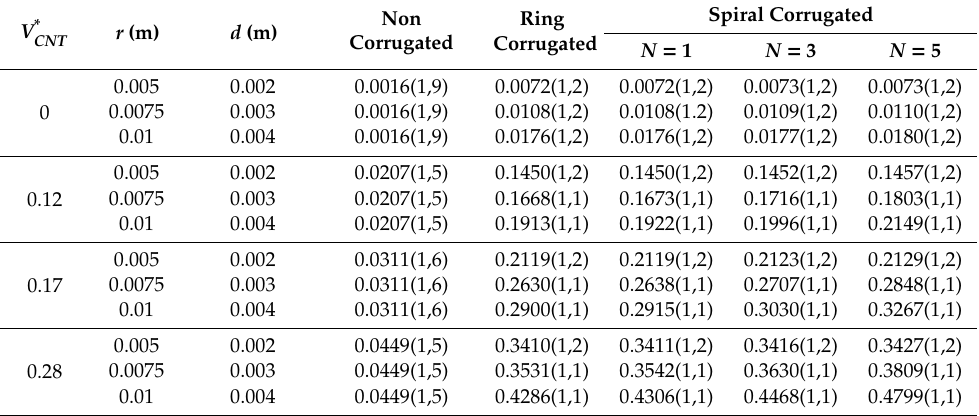
on the critical CNT * V on the CNT